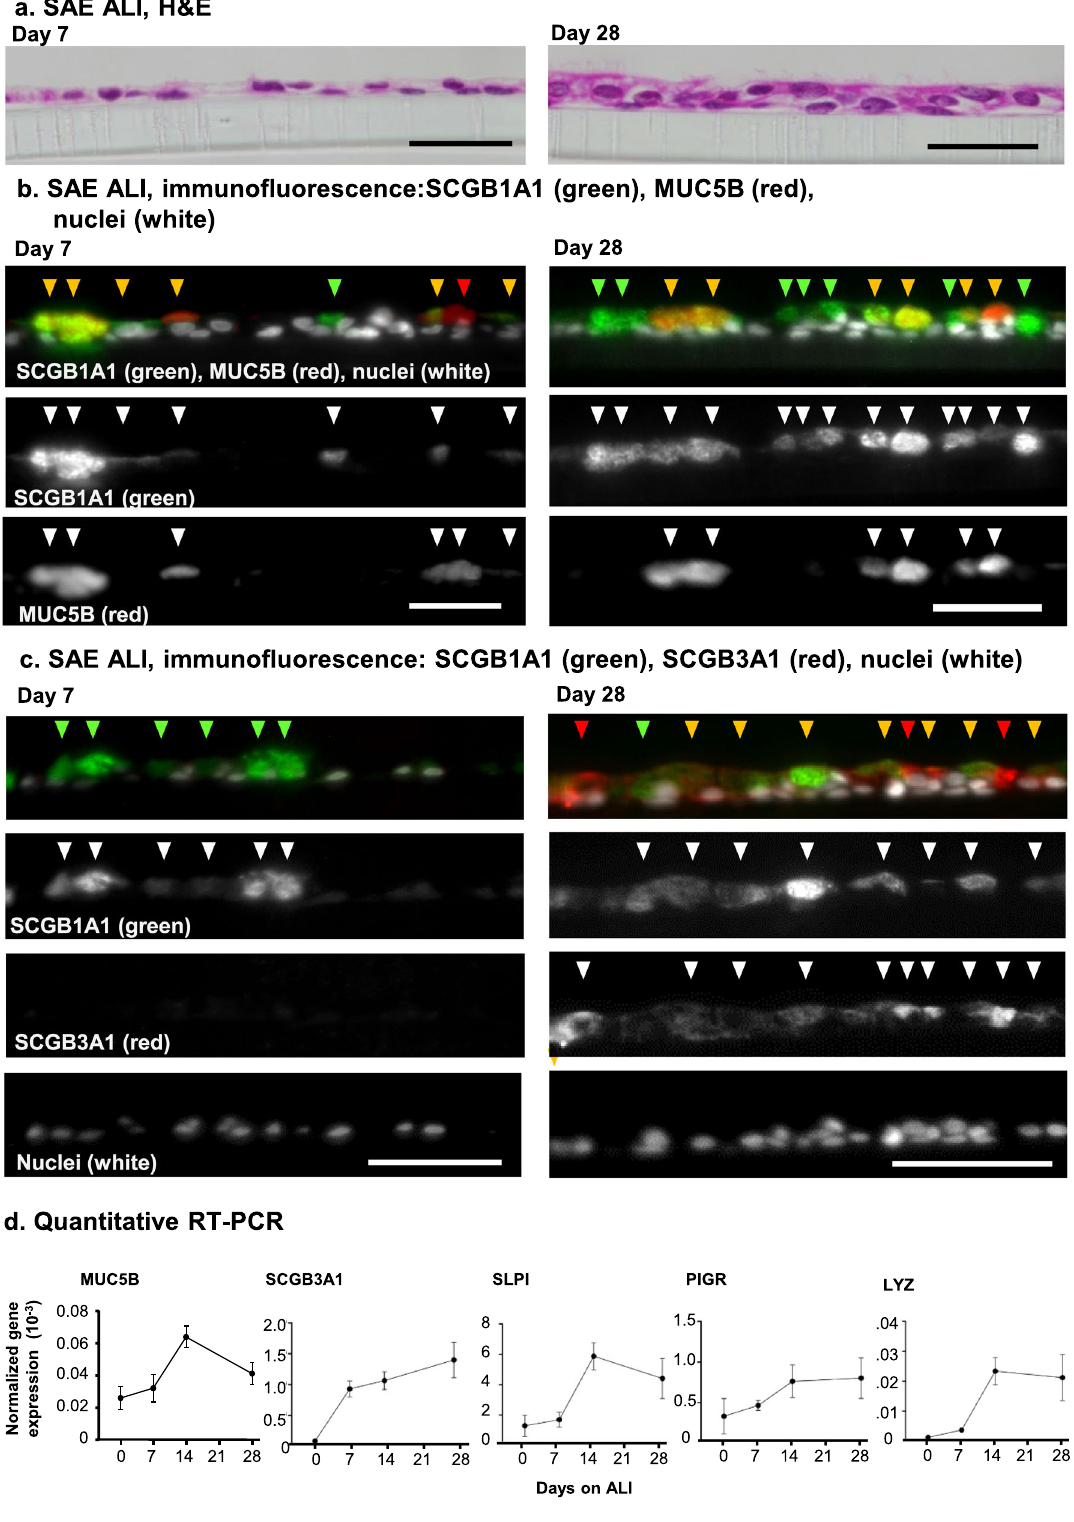
cells that had distinguishing characteristics such as high KRT5 expression suggesting a stem-progenitor function. Consistent with the role of progenitor club cells having pluripotency, the Slingshot pseudotime trajectory analysis identi fi ed this cluster as the branch point for further differentiation of both progenitor club cells